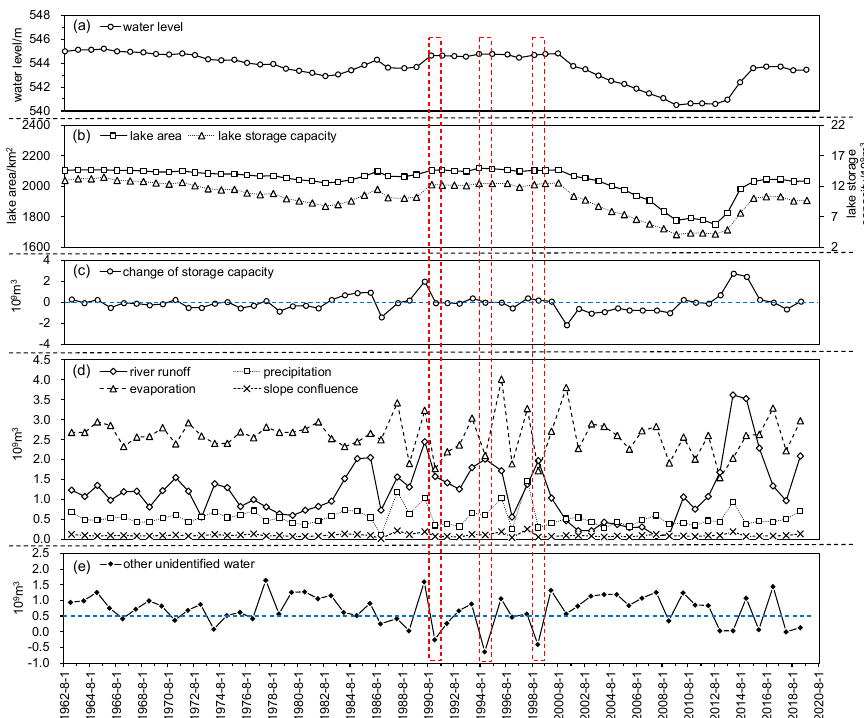
Figure 8. Variations in the equation terms for Hulun Lake over the last 60 years. ( a ) water level, ( b ) area and lake storage capacity, ( c ) change of storage capacity, ( d ) river runoff, precipitation, evaporation and slope confluence, and ( e ) other unidentified water.